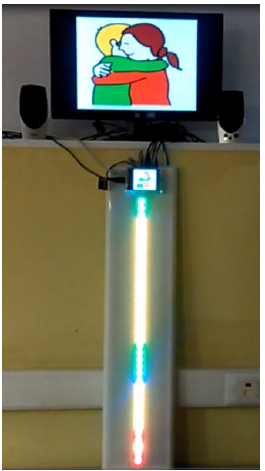
Figure 19. Reward achieved in behavior contention service.